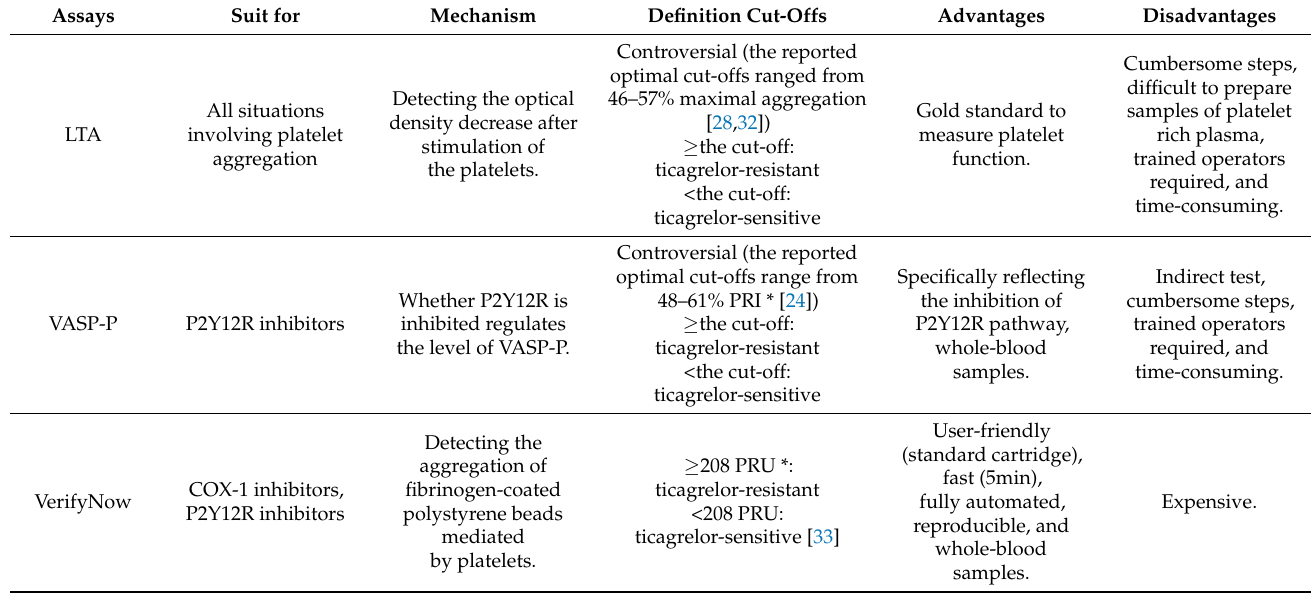
Table 2. Summary of the basic characteristics of the common platelet function